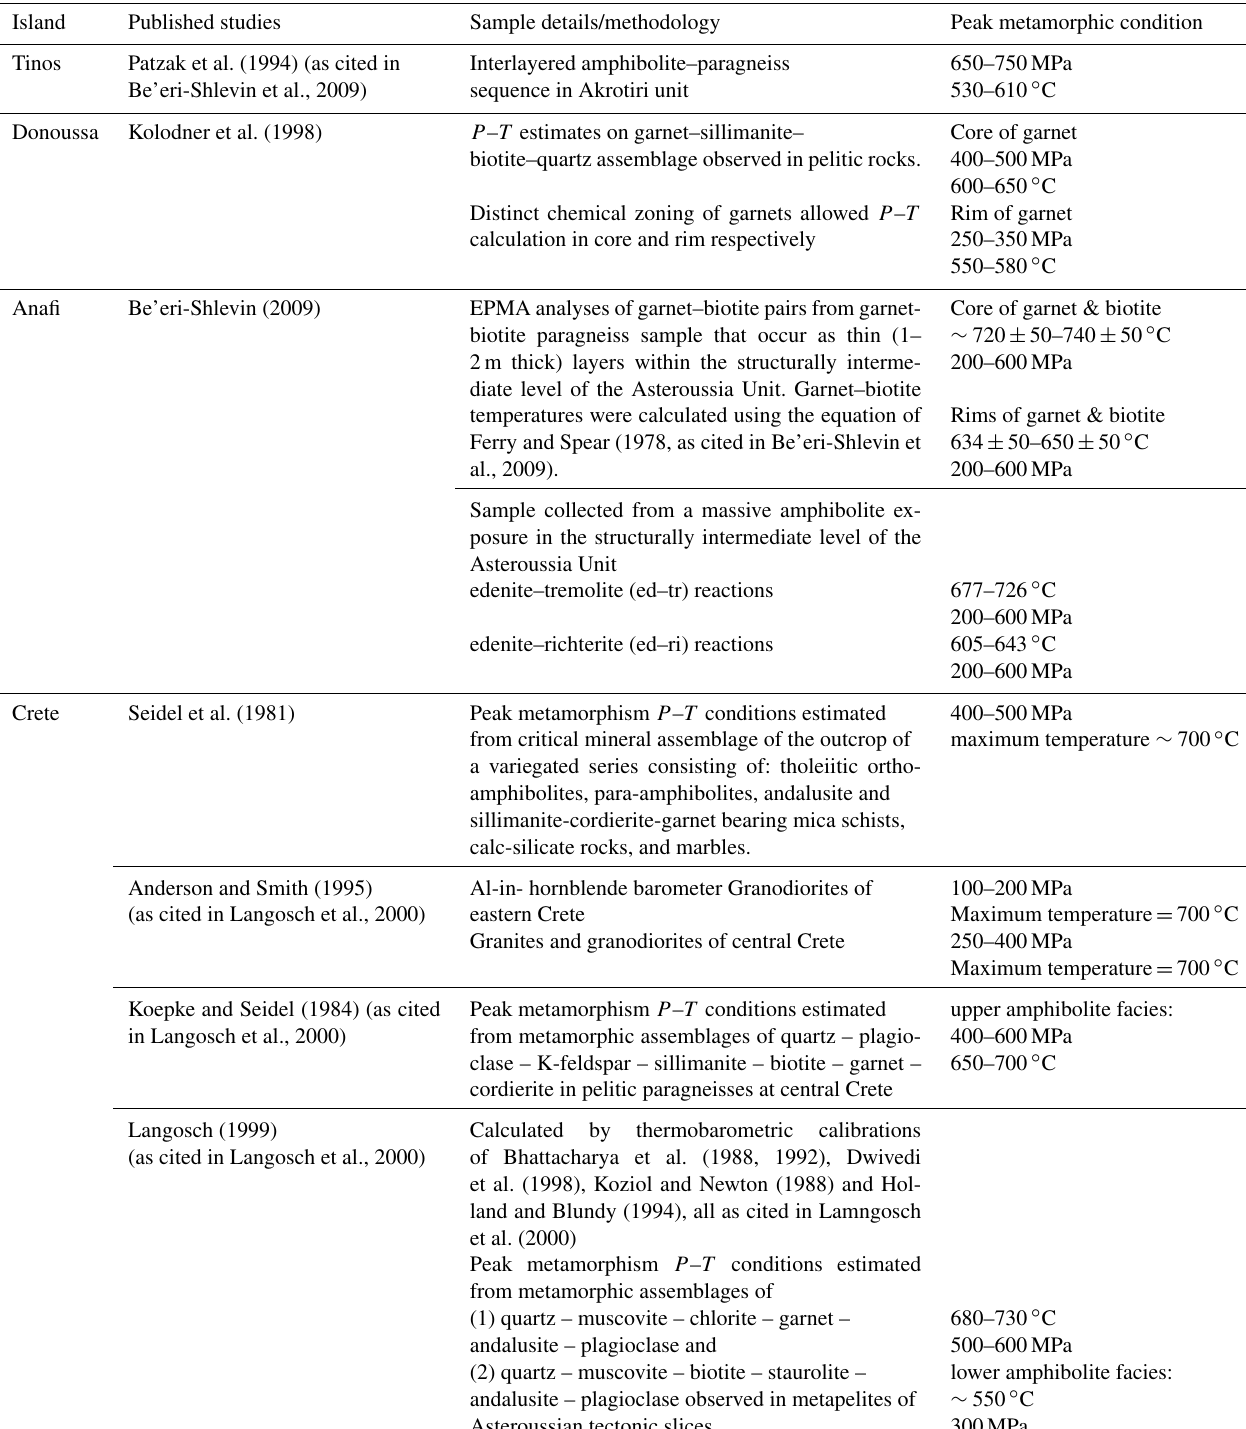
Table 3. Peak metamorphic condition of the Asteroussia event across the cyclades.